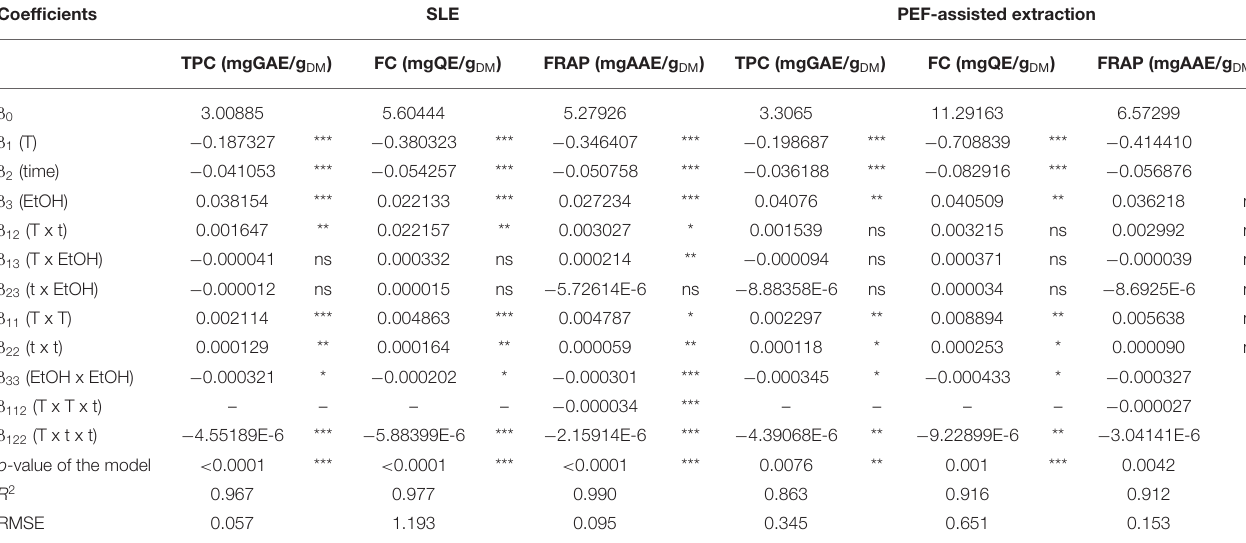
TABLE 4 | Analysis of variance (ANOVA) of the third polynomial models for the TPC, FC, and antioxidant activity (FRAP) in grape pomace extracts from either conventional SLE or PEF (3.9 kV/cm, 10kJ/kg)-assisted extraction process. Coefficients